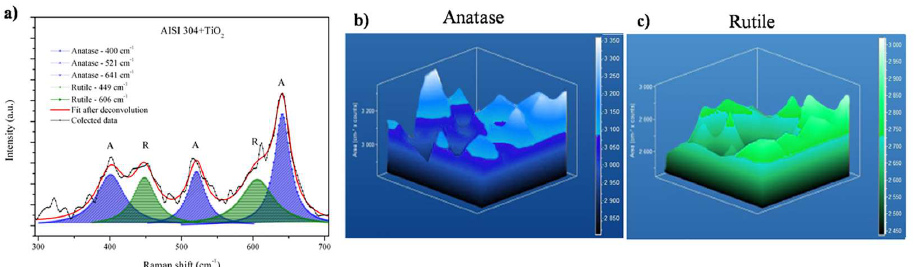
Figure 5. Raman mapping of the AISI 304 + TiO 2 film. ( a ) Overlap of 20 Raman shift plots, with the positions of the anatase (A) and rutile (R) bands, respectively. Three-dimensional Raman mapping of ( b ) the anatase band (from 135 to 175 cm − 1 ) and ( c ) the rutile band (from 595 to 635 cm − 1 ).